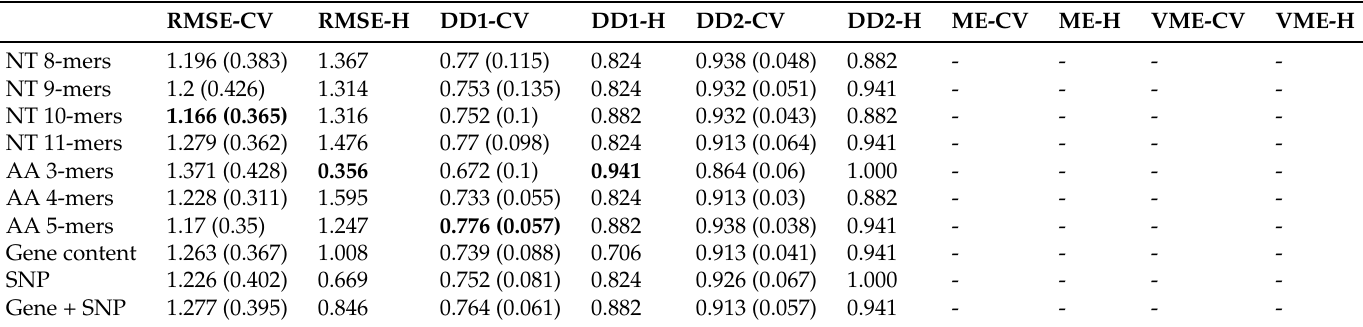
Table A23. N. gonorrhoeae –erythromycin.